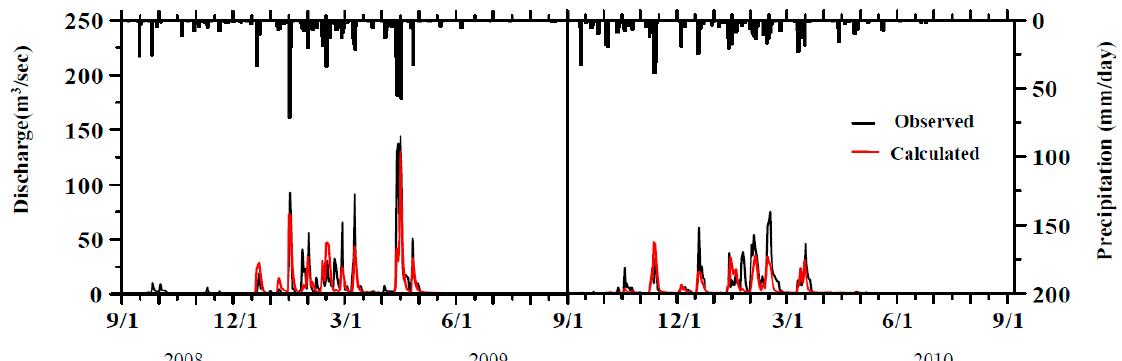
Figure 10. Simulation result of the discharge from Joumine reservoir catchment calibrated with SWAT-CUP.